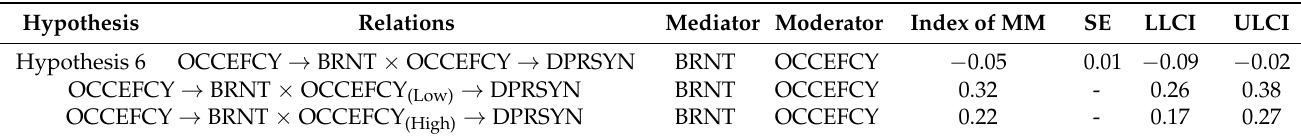
Table 8. Moderated mediation